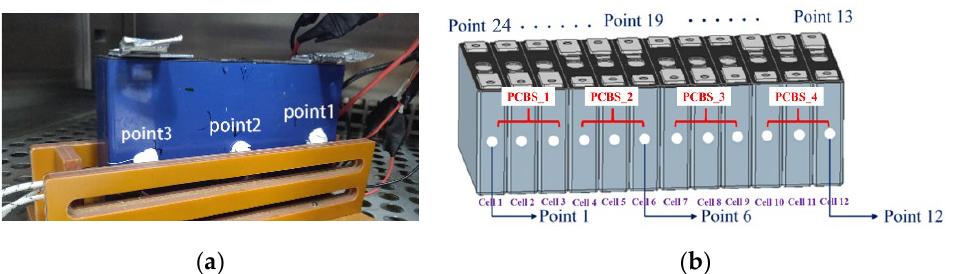
Figure 7. Experimental devices.